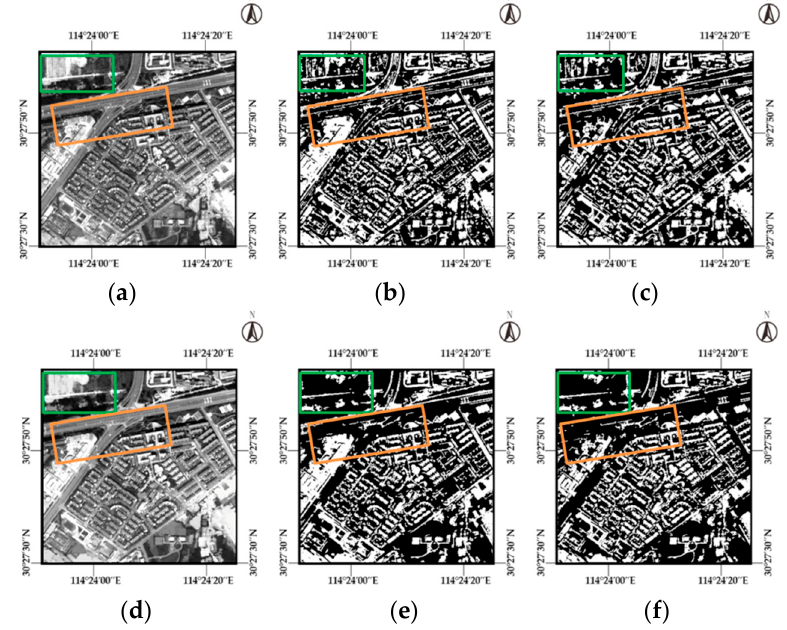
Figure 13. The MBI and MABI feature results based on the bright image and I ʹ for Patches I1 and I5: ( a ) bright image; ( b ) results of the MBI based on the bright image; ( c ) results of the MABI based on bright image; ( d ) image I ʹ . ( e , f ) are the results of MBI and MABI, respectively, based on I ’.